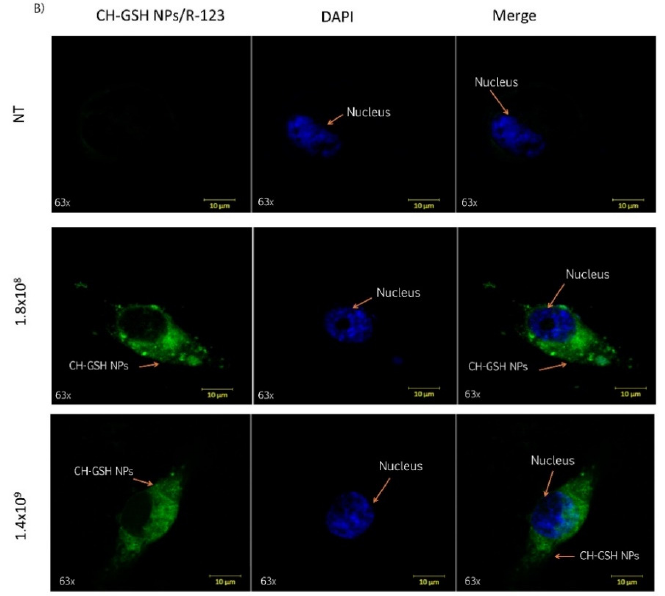
Figure 2. Confocal microscopy images of cells exposed to a concentration of 1.8×10 8 NPs/mL and 1.4×10 9 NPs/mL at the time of 2 h. Untreated cells (NT), A) MCF-7 and B) MDA MB-231 cells.